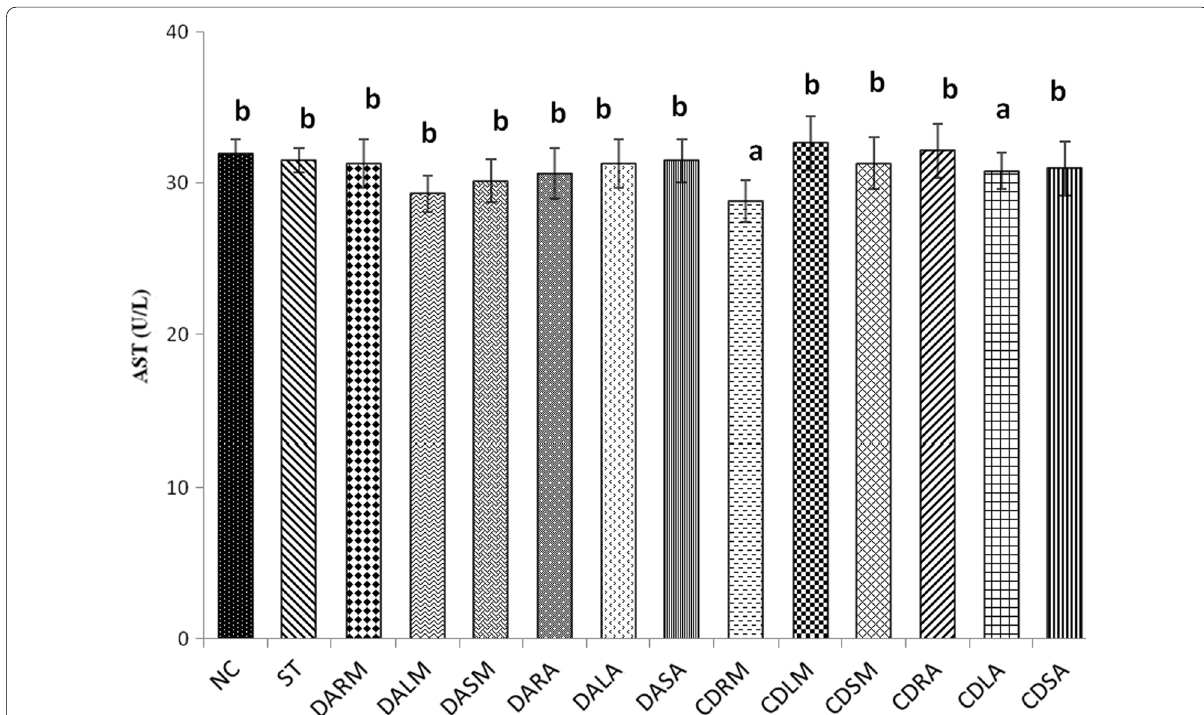
Fig. 9 Effects of administration of methanolic and aqueous extracts of roots, leaves and stem of D. arborescens and C. dependens on Aspartate transaminase (AST) of rats. Bars with similar alphabets are not statistically different ( p <